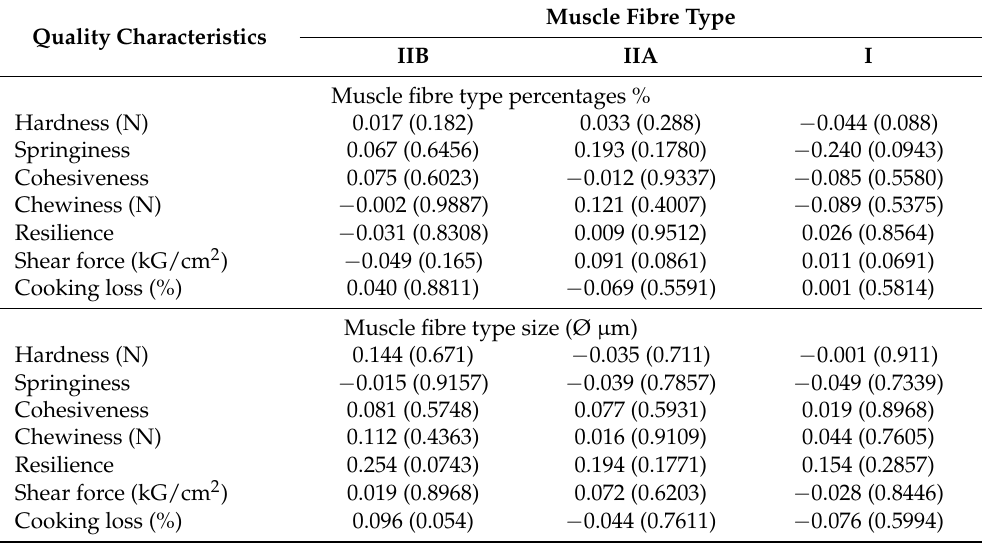
Table 8. Correlation coefficients ® between the quality characteristics of the roasted loin and muscle fibre percentage and fibre type size.